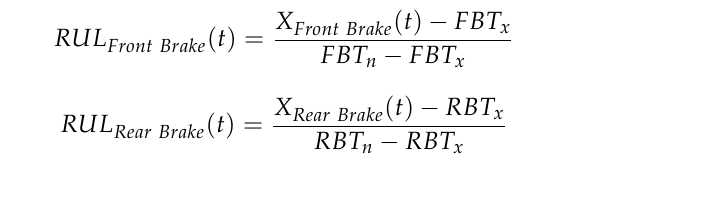
Table 5. Nominal front and rear geometrical brake thickness.